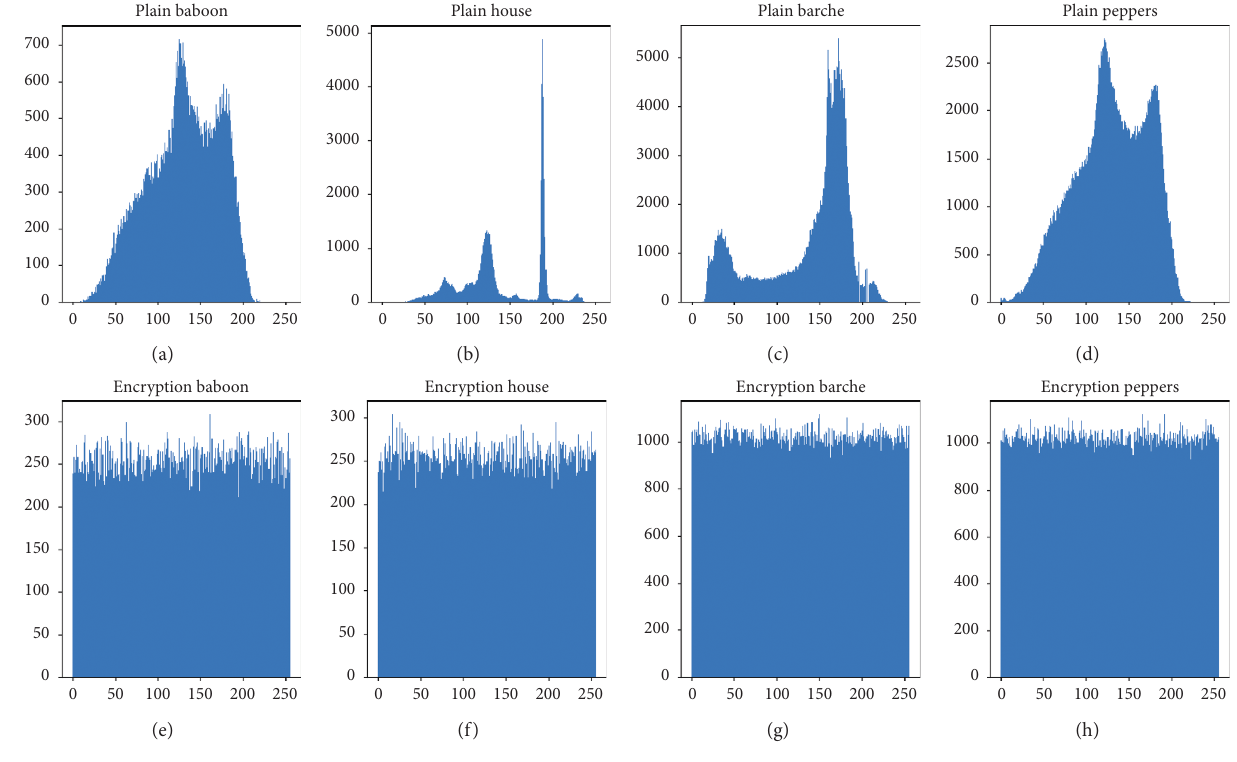
Figure 12: The result of histogram Table 6: Variances of histograms compared among all secret keys.